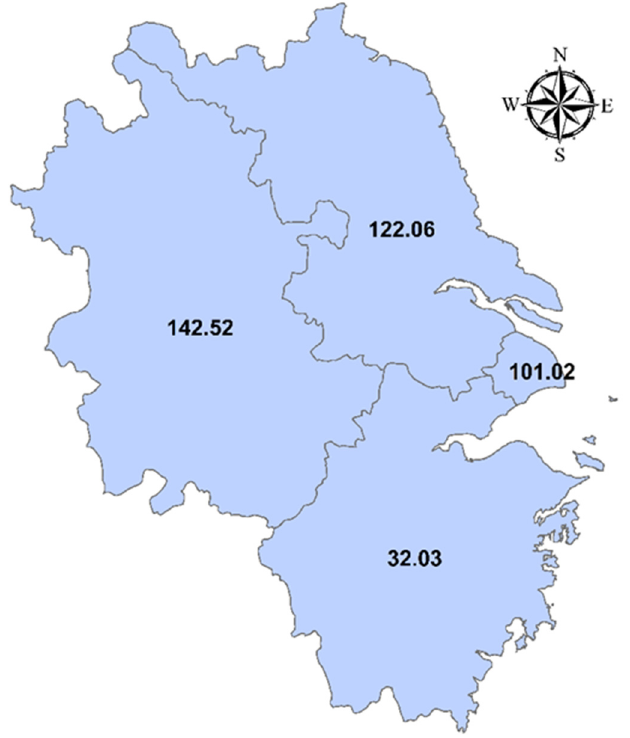
Figure 6. Ratio of potential solar capacity to total installed solar capacity in 2019.